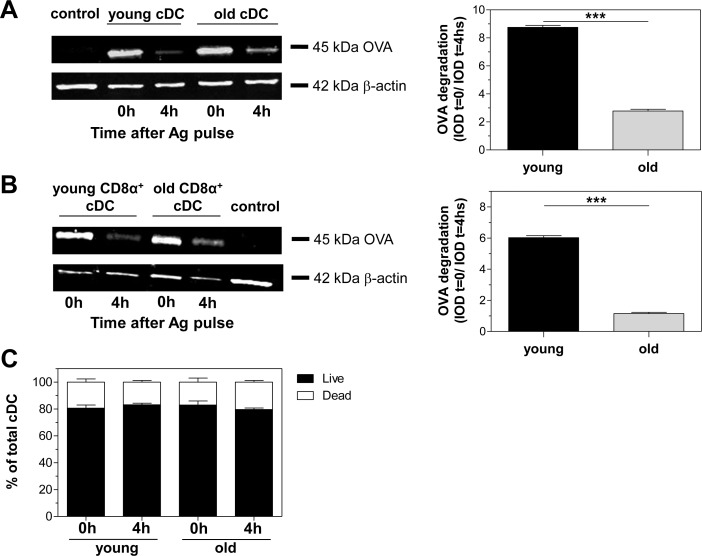
Ag degradation in cDCs is affected by aging.Persistence of OVA protein in cell lysates of total (A) or CD8α+ (B) cDCs purified from young and old mice was determined by Western blot after 1 hour pulse loading with 0.625 mg/mL OVA plus 20 μg/mL polyU/DO (time 0, 0h) and 4h chase. Actin was used for loading control. The control line contains total cell lysates of untouched splenic DCs. Densitometric analysis of Western blots (right) is expressed as the ratio of integrated optical density (IOD) at time 0 relative to IOD at chase time. (C) Percentages of total live and dead cDCs after 1 hour pulse loading and 4h chase. Data represent the mean ± SEM of duplicate cultures and are representative of 2 independent experiments. ***p < 0.001.